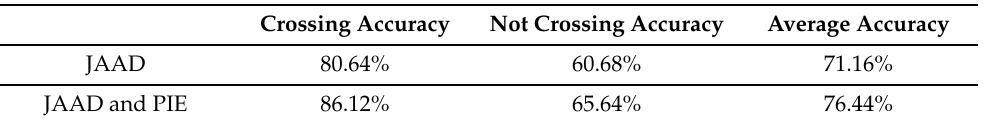
Table 5. Test accuracy of pedestrian cross-attribute recognition using the conventional dense SIFT flow two-stream CNN.